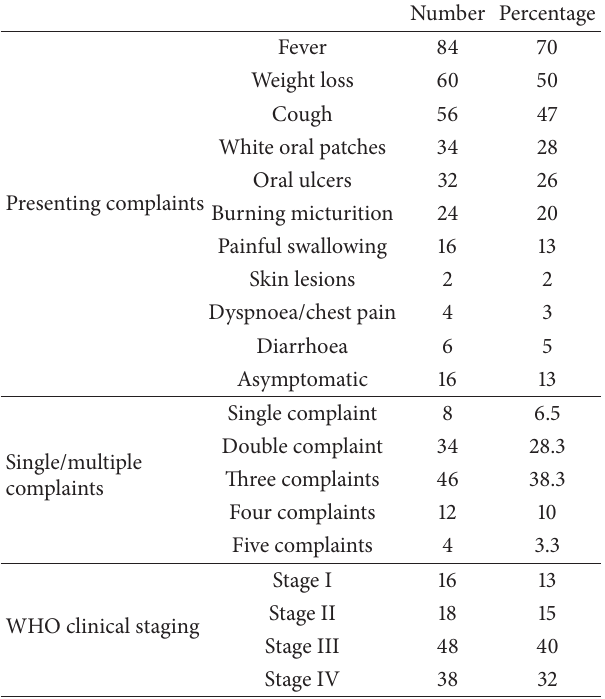
Table 2: Clinical profile of study subjects. 𝑛 = 120